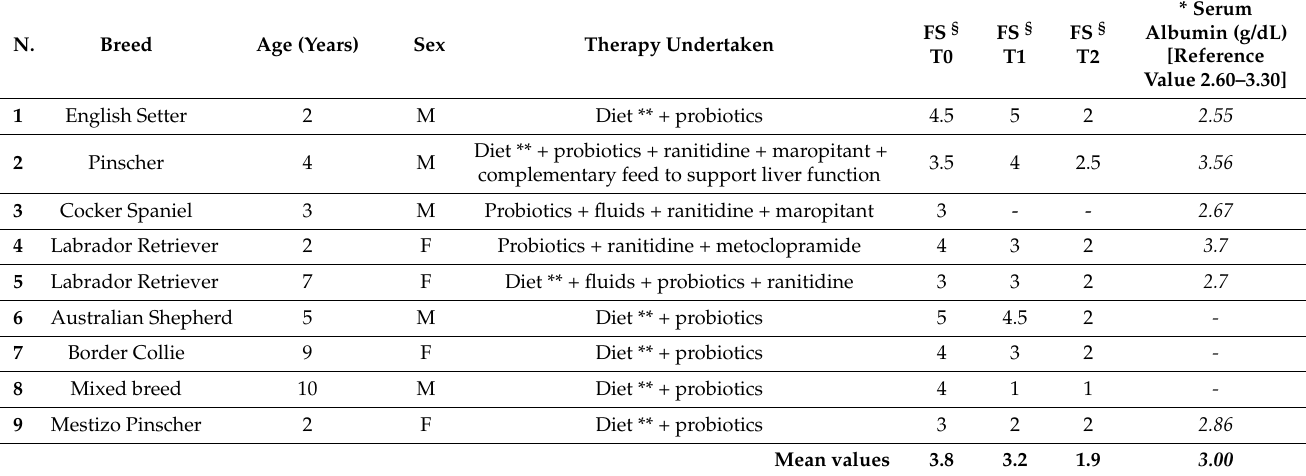
Table 1. Clinical data, fecal score (FS), and serum albumin values (at T0) of the patients included in the